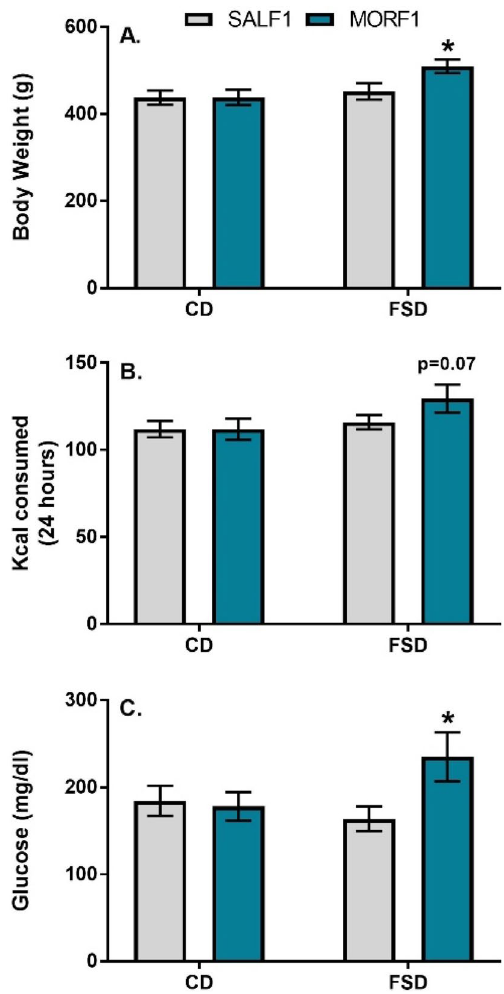
Figure 2. Panel ( A ): Mean (± SEM) bodyweight after 8 weeks on diet; N = 9/group. Panel ( B ): Mean (± SEM) food consumption in kilocalories over a 24 h period after 8 weeks on diet; N = 9/group Panel ( C ): Mean (± SEM) blood glucose following a 24 h fast; N = 9 for all groups but SALF1 FSD with N = 8 due to removal of statistical outlier; * p < 0.05 as compared to SALF1